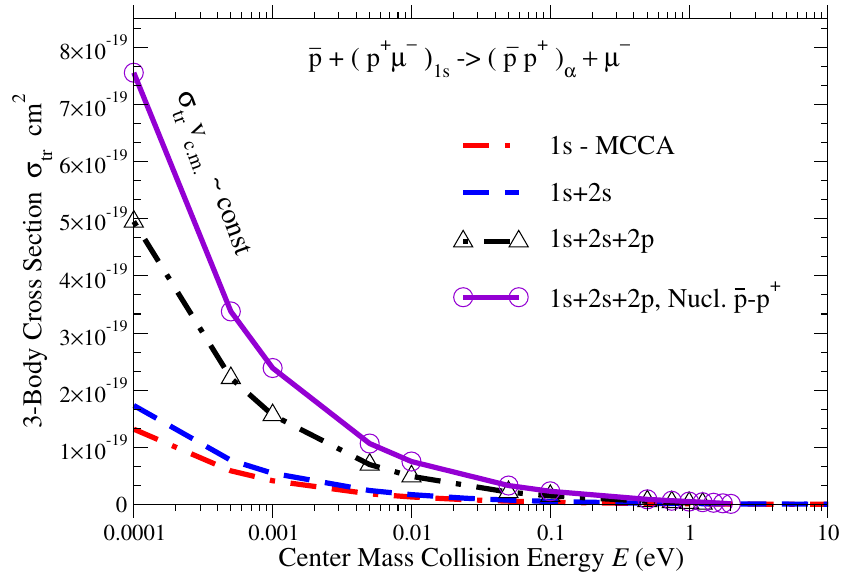
Figure 3. This figure shows final results (after numerical convergence test calculations) for the low-energy proton transfer reaction 3-body integral cross section σ tr , i.e., ¯p + H µ → ( ¯pp ) α + µ − . Here, H µ is a muonic hydrogen atom: a bound state of a proton and a negative muon. The reaction’s final channel with α = 1s is only considered in this paper in the framework of the 1s, 1s + 2s and 1s + 2s + 2p MCCA approach. The solid line with open circles is the result with an approximate inclusion of the final state strong ¯p-p + nuclear